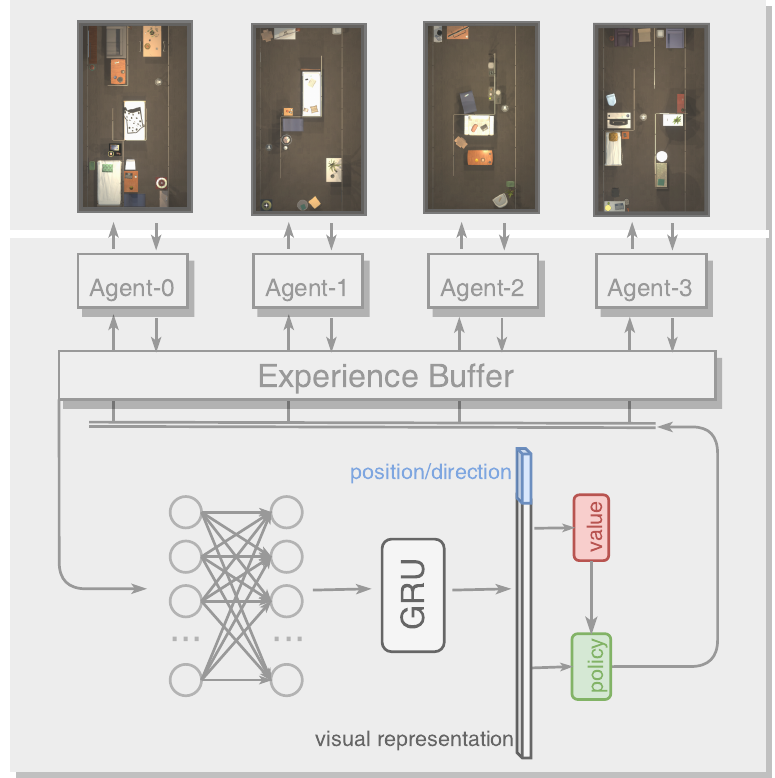
Figure 3. Policy learning implementation. The top row is the environment set used to train the agent. The bottom part is the shared Actor-Critic